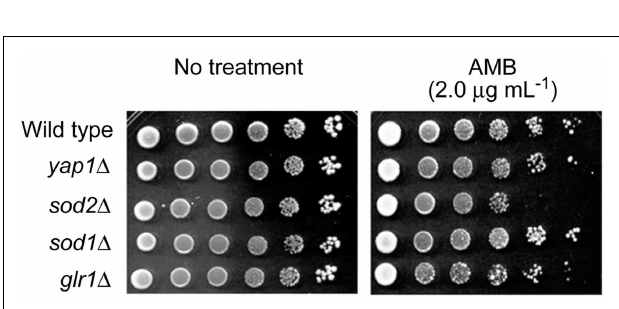
FIGURE 2 | Dilution bioassay showing phenotypic responses of S. cerevisiae strains to amphotericin B (AMB). S. cerevisiae sod2 ∆ [mitochondrial superoxide dismutase (Mn-SOD) gene deletion] mutant exhibited increased sensitivity to AMB over that of other deletion mutants ( yap1 ∆ , sod1 ∆ , and glr1 ∆ ) involving antioxidation responses. Data are representative results shown from 2 µ gmL − 1 (AMB). 1 × 10 6 cells were serially diluted 10-fold in SG liquid medium, and were inoculated onto agar